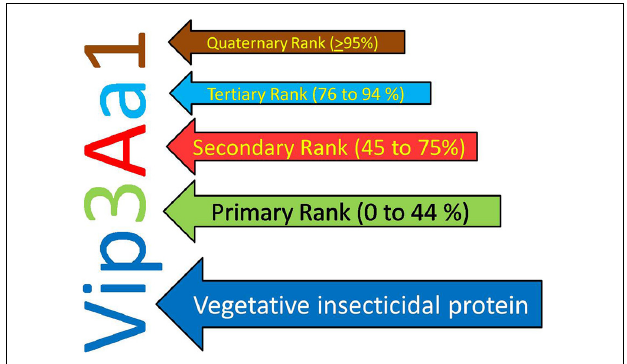
FIGURE 1 | New nomenclature criteria for Vegetative Insecticidal Protein given by nomenclature committee.